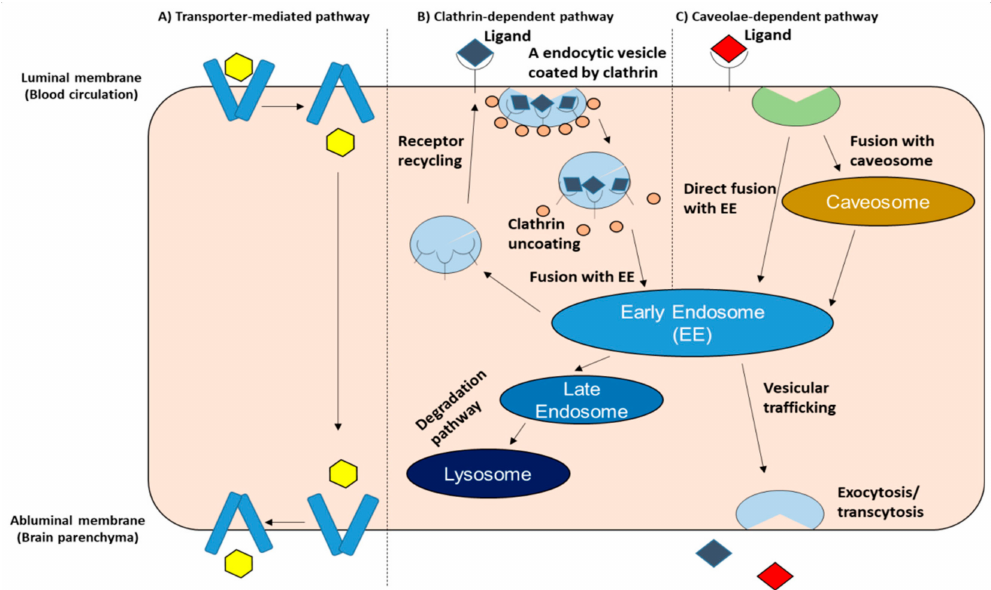
Figure 4. Main internalization pathways for receptors / transporters expressed on the BBB. (A)